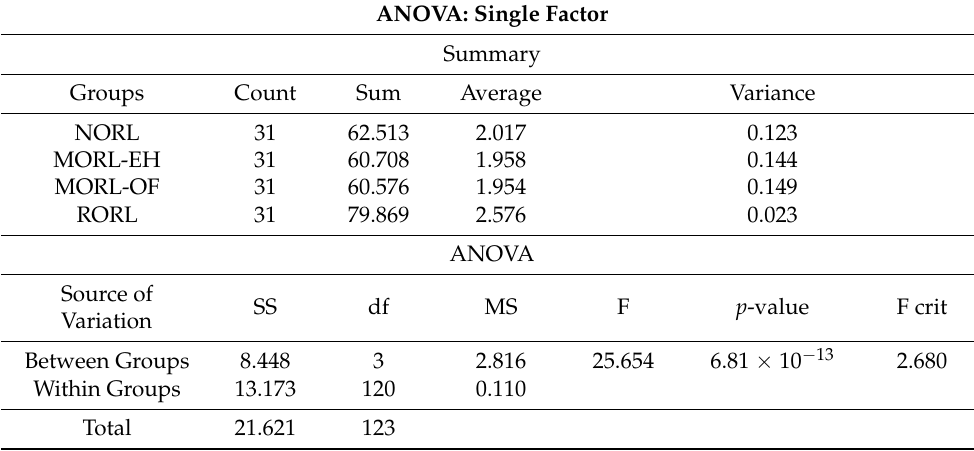
Table 6. Summary of ANOVA results from instantaneous